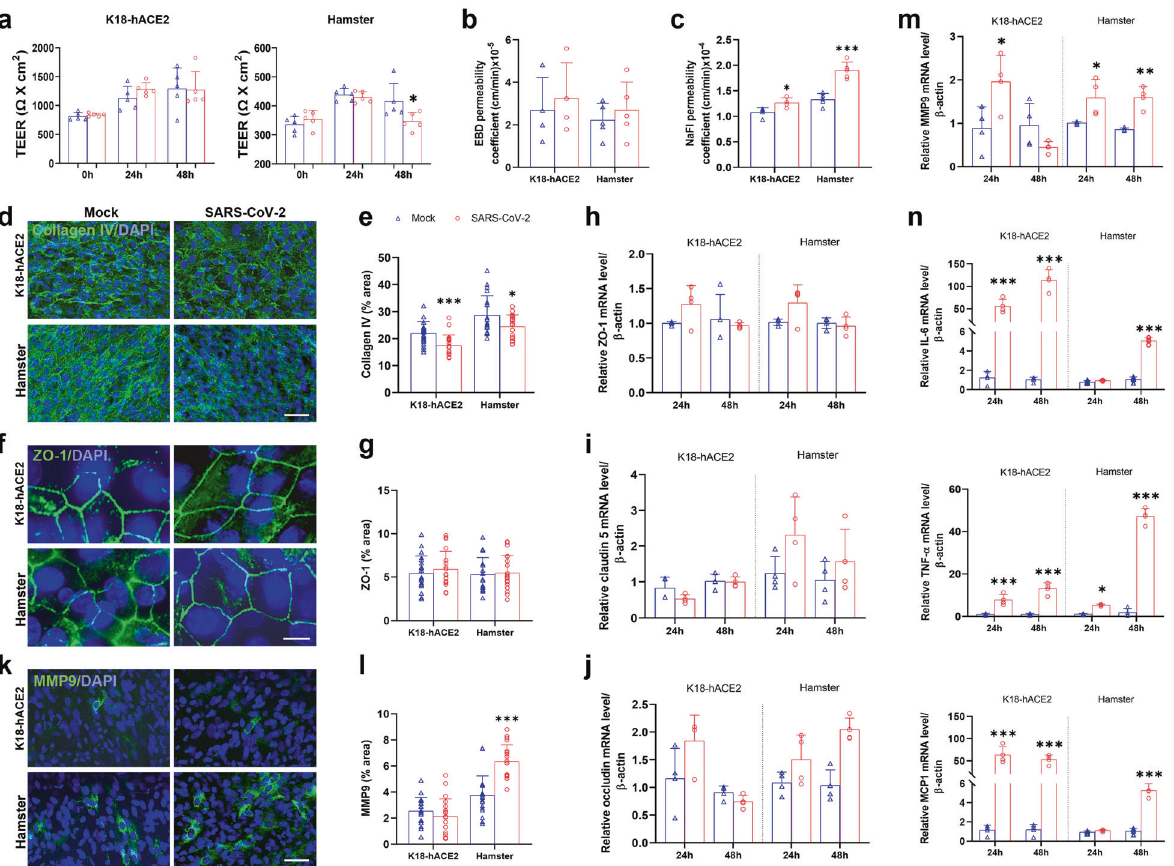
Fig. 5 SARS-CoV-2 disrupted BBB without tight junction impairment in vitro. a The transendothelial electrical resistance (TEER) was recorded in primary transwell cultures of BMECs from both K18-hACE2 mice and hamsters infected at an MOI = 1 ( n = 5/group). b The permeability of Evans blue dye (EBD) ( n = 4/group) and c fl uorescein sodium (NaFl) in the K18-hACE2 mice and hamster BBB models at 48 hpi ( n = 5/group). d Representative images showing immuno fl uorescent staining for collagen IV in BMECs at 48 hpi. e Semi-quantitative analysis of area fraction of collagen IV immuno fl uorescent staining ( n = 20 fi elds/group at ×200). f Representative images showing ZO-1 immuno fl uorescent staining in BMECs at 48 hpi and g its semi-quantitative analysis. h – j Relative mRNA levels of TJ-related proteins, including ( h ) ZO-1, claudin5 ( i ), and j occludin detected by RT-PCR ( n = 4/group). k Immuno fl uorescence images for MMP9 in BMECs at 48 hpi. l Histograms for MMP9 quantitative analysis (20 fi elds/group were analyzed at ×400). m Relative mRNA level of MMP9. n Relative mRNA level of in fl ammatory factors in the medium from the upper chamber at 48 hpi ( n = 4/group). The p -values were determined by two-way ANOVA ( a , h – j , m , n ) and two-tailed unpaired Students ’ t- test ( b , c , e , j , l ). * p < 0.01, ** p < 0.01, *** p < 0.001. Scale bars: d , k 50 μ m; f 10 μ microvascular endothelial cells in vitro without ef fi cient replica- tion. 10 In contrast, Schaefer et al. found no evidence of the virus in post-mortem pulmonary endothelial cells of COVID-19 patients with diffuse alveolar damage by immunohistochemical staining. 36 And multiple studies challenge the identi fi cation of “ virus-like particles ” in endothelial cells under EM as coronavirus particles. 37 – 39 were resistant to infection with SARS-CoV-2. 40,41 These disparate fi ndings could be due to the organ-speci fi c heterogeneity of the endothelium, and endothelial cells show tissue- and vascular bed- speci fi c pro fi les that may regulate their susceptibility and permissibility to SARS-CoV-2 infection. 12,42,43 Besides tissue- and vascular bed-speci fi c pro fi les, these inconsistent results in viral